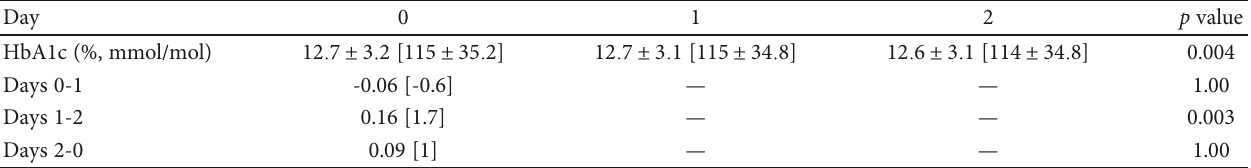
Table 2: Mean HbA1c changes.